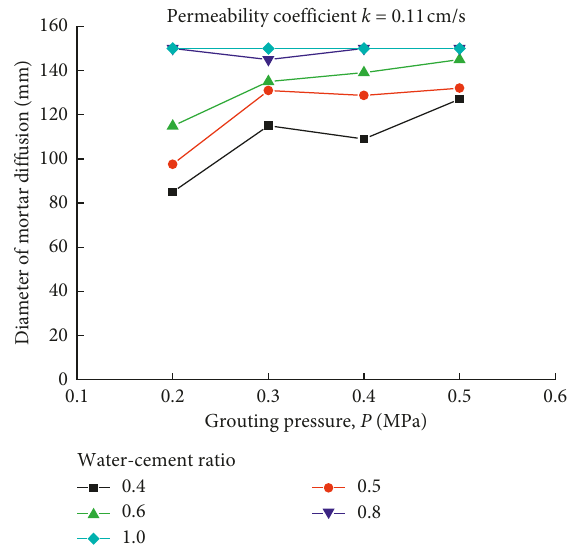
Figure 10: Characteristics of slurry diffusion ( k